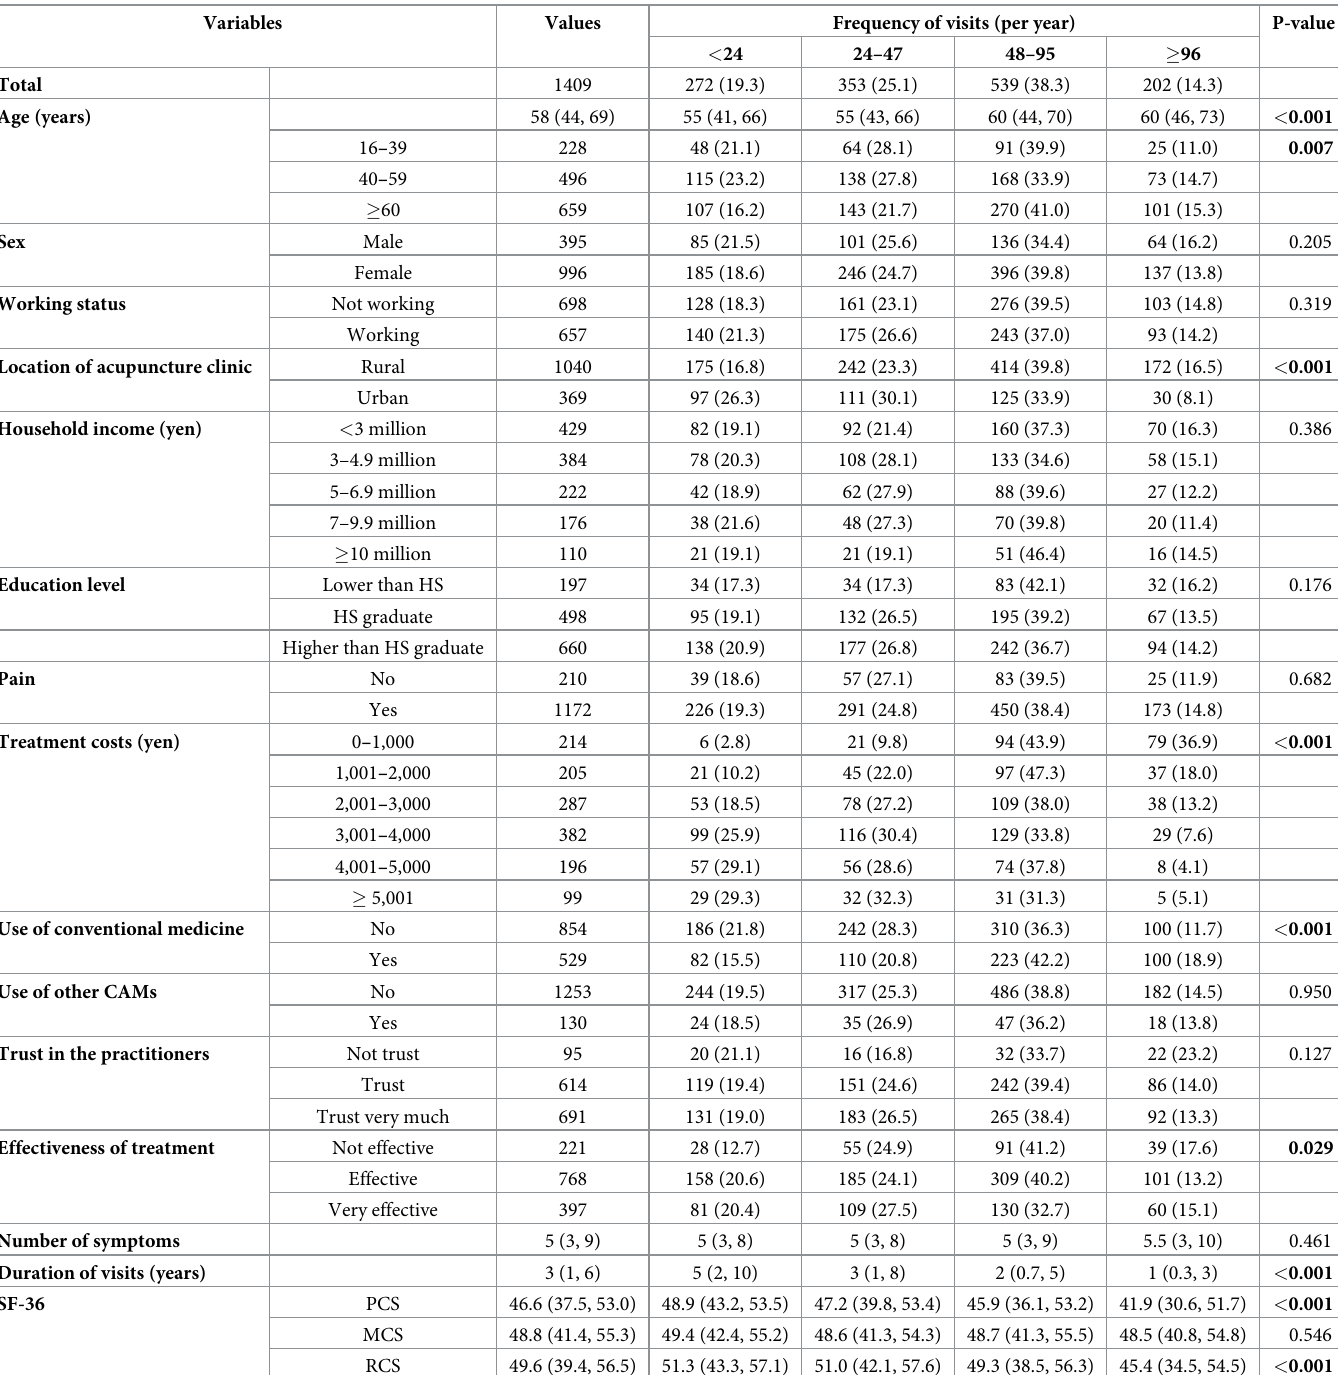
Table 2. Patient characteristics by visit frequency of acupuncture